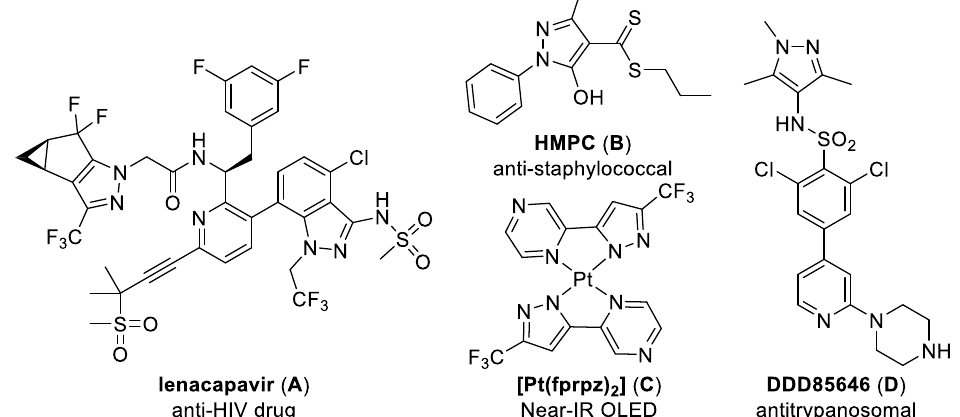
Figure 1. Some examples of biologically active and metal-coordinating pyrazoles.